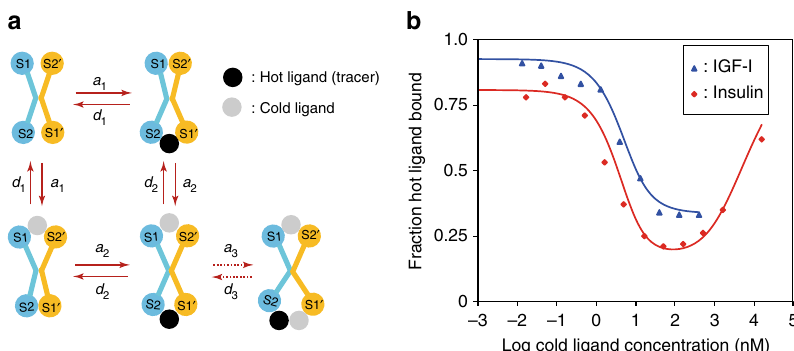
Fig. 8 Induced fi t binding of ligand to IGF-1R and IR. a Proposed kinetic scheme. S1, S2: site 1 and site 2 on one receptor monomer; S1 ΄ , S2 ΄ : site 1 and site 2 on the opposing receptor monomer. Black fi lled circle: hot ligand (i.e., IGF-I, IGF-II or insulin). Grey circle: cold ligand (i.e., IGF-I, IGF-II or insulin). a 1 and d 1 : ligand association and dissociation rate constants for the high-af fi nity site. a 2 and d 2 : ligand association and dissociation rate constants for doubly liganded, symmetrical receptor conformation. a 3 and d 3 : association and dissociation rate constant for binding of a third insulin molecule (IR only, not applicable to IGF-1R). b Plot for accelerated dissociation of a pre-bound tracer-labelled ligand by cold (unlabelled) ligand. The dissociation time was 20 min. The experimental data were as described previously (reproduced in Supplementary Table 4) 18 and are shown as blue triangles for IGF-1 and red diamonds for insulin, with the fi t of the induced- fi t model to these data shown as lines (IGF-I blue; insulin